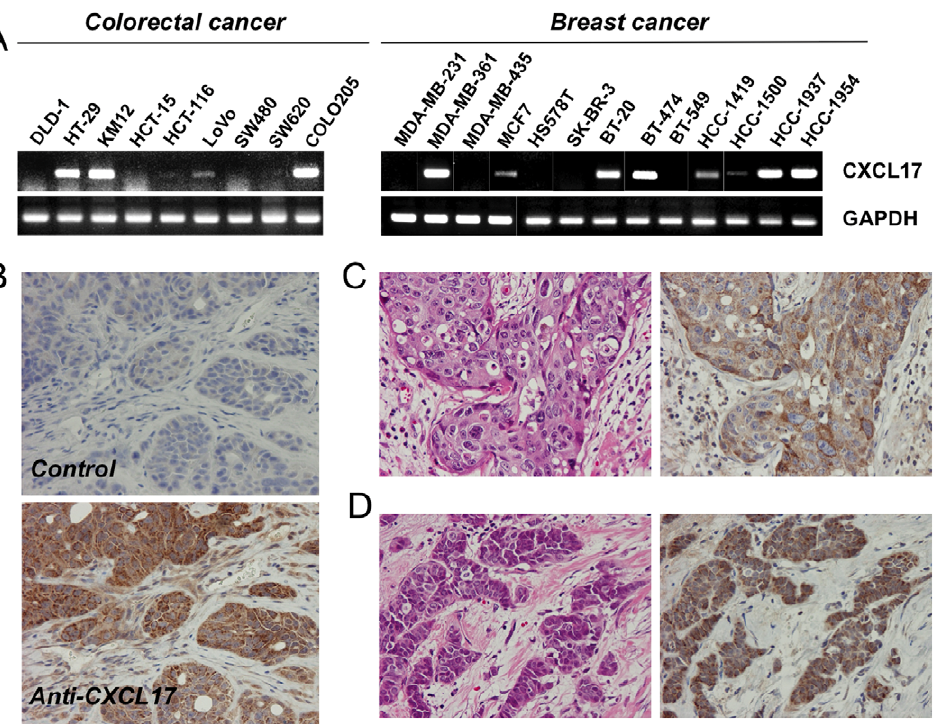
Figure 2. CXCL17 mRNA expression in various human cell lines. (A) Analysis of human CXCL17 mRNA expression in human colon and breast cancer cell lines using RT-PCR. Upper panel, CXCL17; lower panel, GAPDH as an internal control. Cell line names are indicated on each panel. (B) Immunohistochemistry for CXCL17 in the representative xenograft of HT-29 cells, using normal rabbit IgG (upper panel, control) and anti-human CXCL17 IgG (lower panel). Magnification is 6 100. The brown color (3,3 9 -diaminobenzidine) indicates positive staining. Surgically resected colon (C) and breast (D) cancers were probed with anti-human CXCL17 antibodies. Representative images are shown (see Materials and Methods ). Magnification is 6 100. Upper panel, H&E staining; lower panel, anti-human CXCL17 IgG.